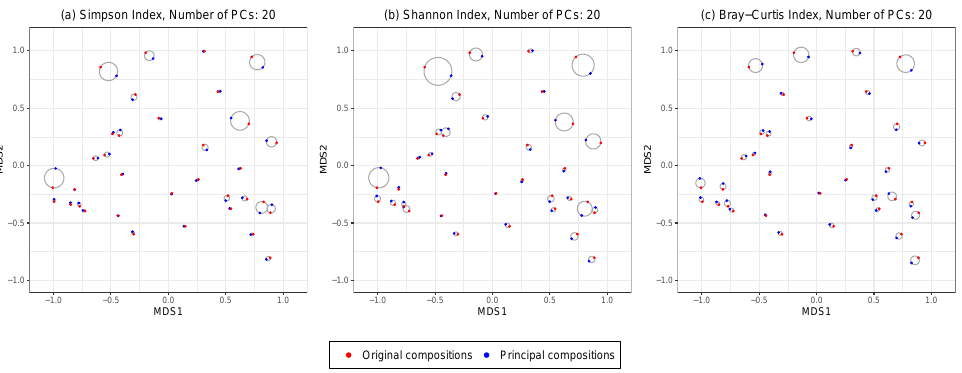
Figure 5. The NICU data: 2D NMDS ordination plots for comparing original and principal composi- tions from HPAA with ( a ) Simpson’s index, ( b ) Shannon’s index and ( c ) Bray-Curtis dissimilarity under weak taxonomic